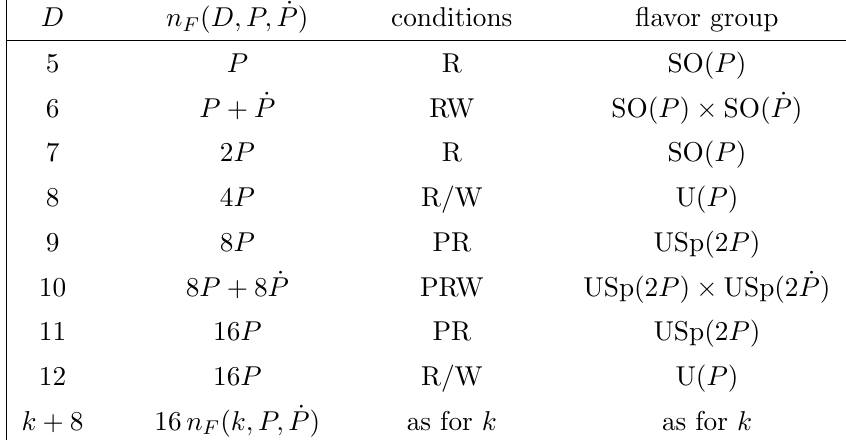
as for k as for k Table 1 . Parameters in the construction of N = 2 homogeneous Maxwell-Einstein supergravities as double copies. The second column gives the number n F of irreducible spinors once the non- supersymmetric gauge-theory factor is reduced to 4 D . Reality (R), pseudo-reality (PR) or Weyl (W) conditions are used to obtain irreducible spinors in D